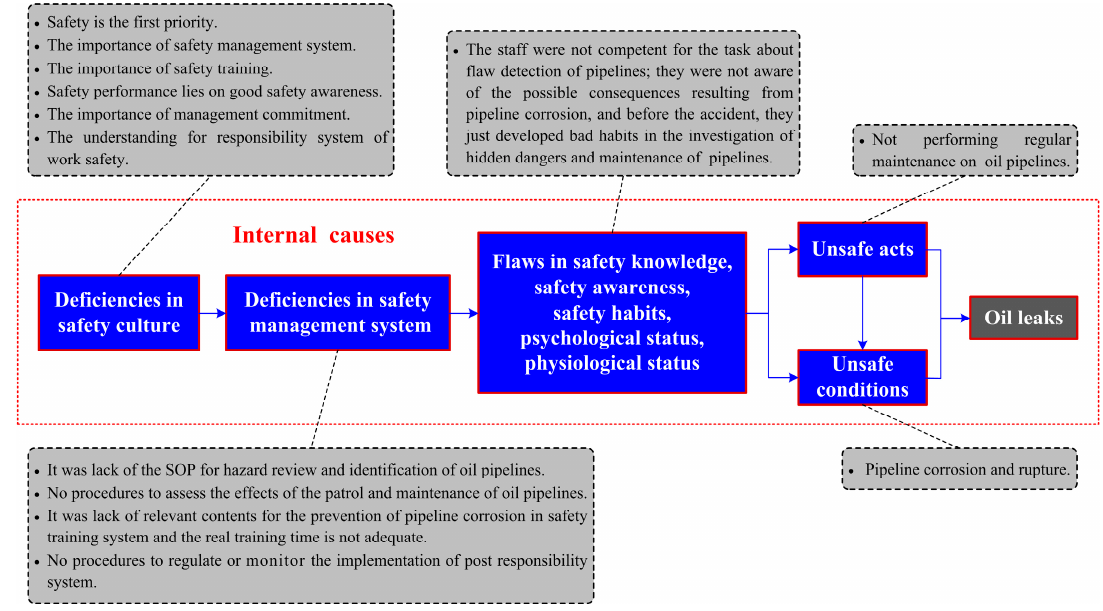
Figure 6. Causes analysis of oil leaks based on the accident causation model. SOP: standard operating procedure.